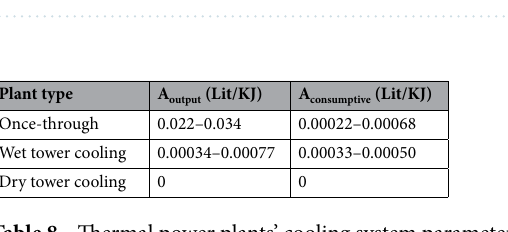
Table 8. Thermal power plants’ cooling system parameters values 74 .